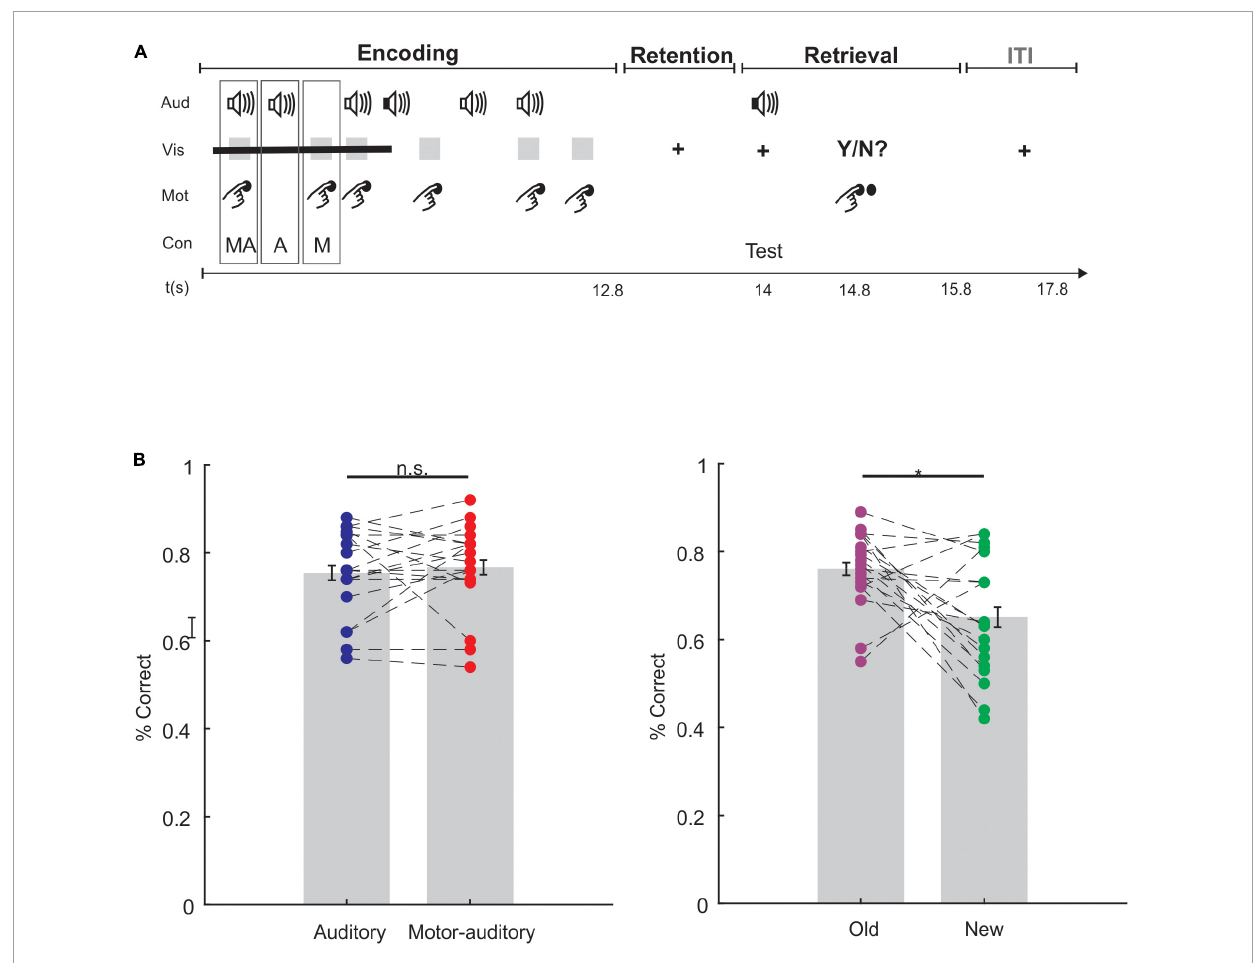
FIGURE1 (A) Schematic description of a trial depicting the visual (Vis), auditory (Aud), and motor (Mot) occurrences taking place, and highlighting an example event for each condition (Con): motor-auditory (MA), auditory (A), and motor (M). Time in seconds, t(s): the timepoints mark the beginning of each phase of the trial. ITI, inter-trial interval. Finger used to generate sounds was the thumb. (B) Behavioral results. Bar plots with individual data points comparing the memory performance for the encoded as motor-auditory and encoded as auditory (left) and for the Old and New (right) sounds at retrieval. Individual data points are connected by a discontinuous line in each comparison. Error bars display the standard error of the mean (SEM). Asterisk denotes statistical